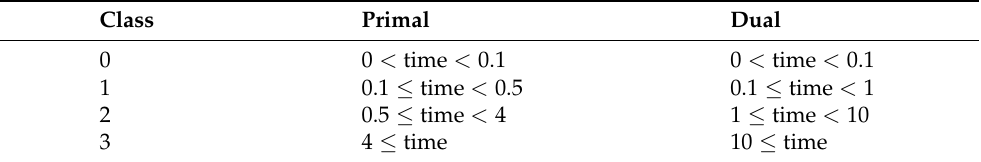
Table 7. Classes of the primal and dual simplex algorithm execution time (in